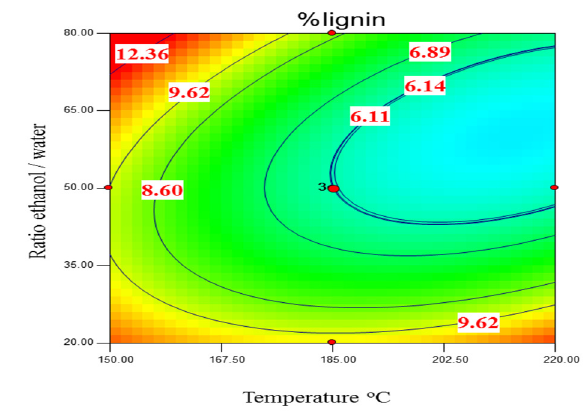
Fig. 5. Effect of temperature and ratio on lignin percent at constant time 50 min .